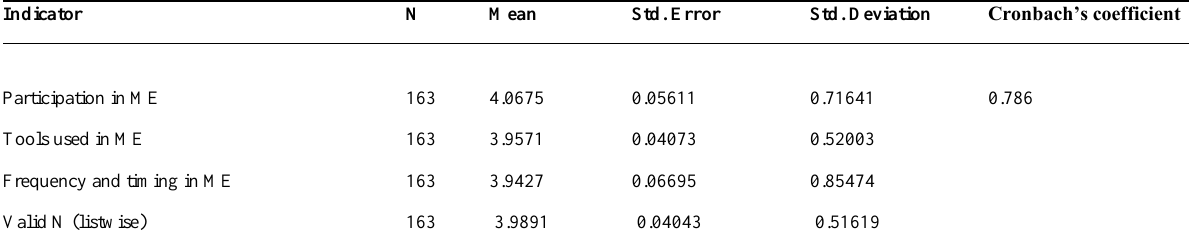
Table 4: Composite descriptive findings for monitoring and evaluation and sustainability of donor funded livelihood projects Indicator N Mean Std. Error Std. Deviation Cronbach’s